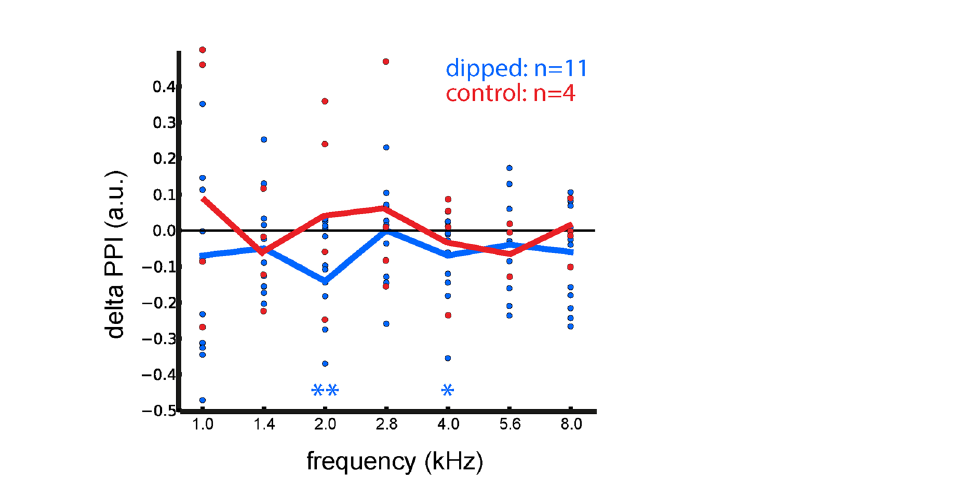
Figure 2. Acute behavioral signs of tinnitus. Immediately after long-term notched noise exposure, mean ∆PPI values (blue) are significantly negative at 2 and 4 kHz (2 kHz: p < 0.01, t value − 3.11519, df 11; 4 kHz: p < 0.05, t-value − 2.27799, df 10; two-sided paired t-test, Bonferroni corrected for multiple testing). In contrast, PPI values of the control animals (red) do not change